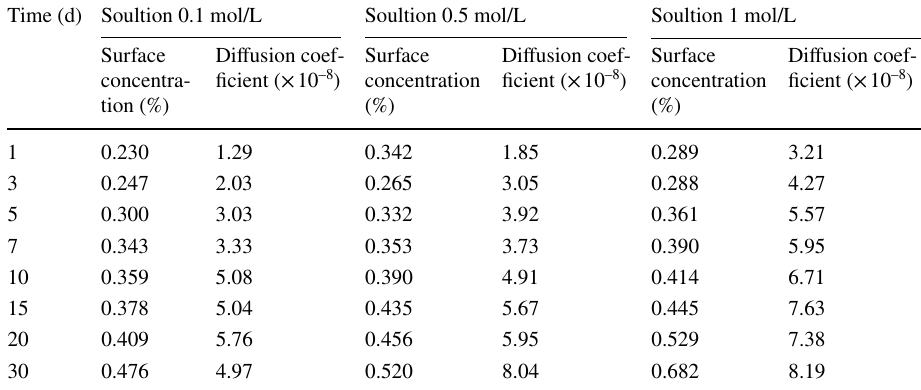
Table 2 Surface sulfate concentration and diffusion coefficient for different exposure time